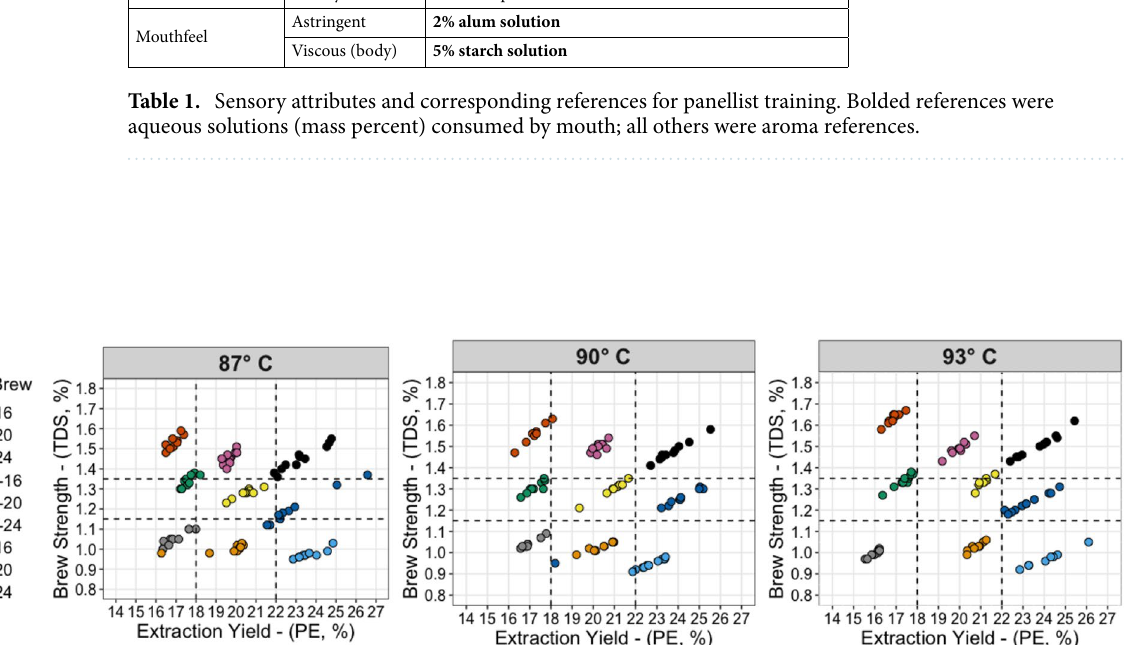
Figure 2. Coffee brewing extraction profiles measured during sensory trials (n = 9 for each target brew, N = 270 total brews), at three different brew temperatures. Code in legend denotes TDS-PE target value. Vertical and horizontal dashed lines denote the zones in the classic Coffee Brewing Control Chart (cf. Fig. 1). See Supplementary Table S1 for all brewing parameters and statistical